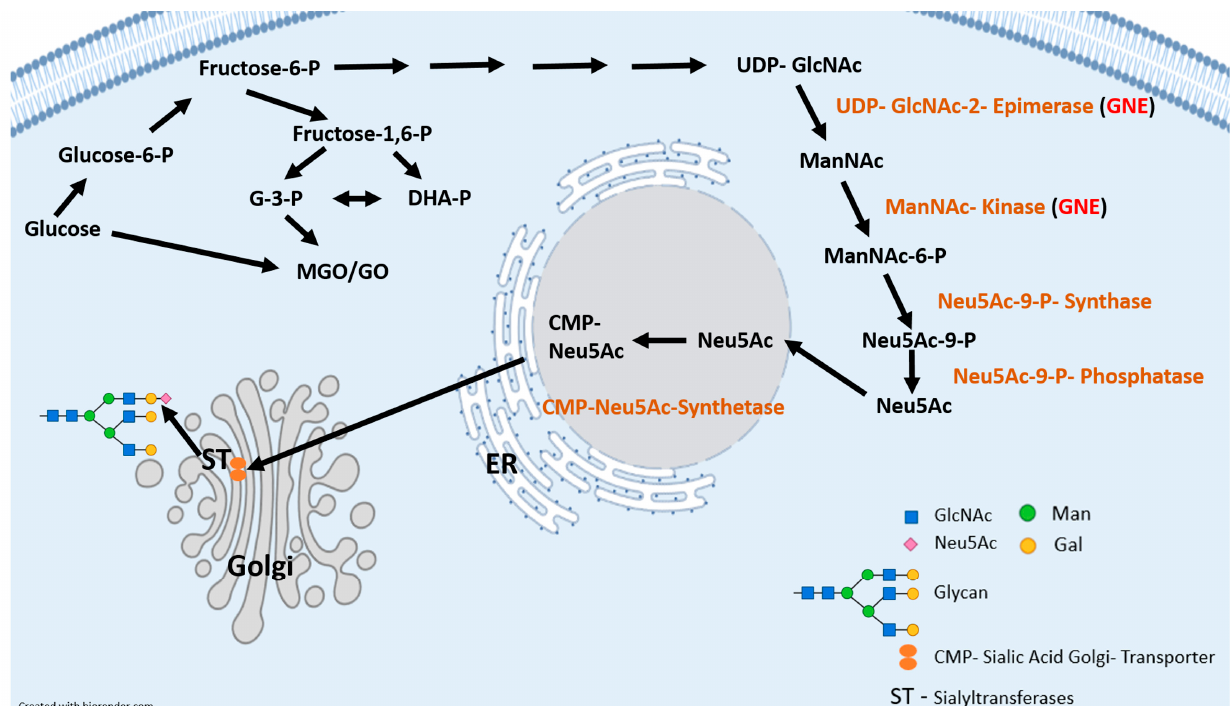
Figure 1. Schematic representation of the Sia biosynthesis from glucose to Sia and glycation agents (MGO/GO) and sialylation of glycoproteins (i.e., N -glycans, O -glycans or gangliosides) in the endoplasmatic reticulum and Golgi. G-3-P = glyceraldehyde-3-phosphate; DHA-P = Dihydroxyaceton phosphate; MGO = methylglyoxal; GO = glyoxal; GlcNAc = N -acetyl-glucosamine; Man = Mannose; Gal = Galactose; Neu5Ac = N -acetyl-neuraminic acid; GNE = UDP- N -acetyl glucosamine 2-epimerase/ N -acetyl mannosamine kinase; ER = Endoplasmatic reticulum.